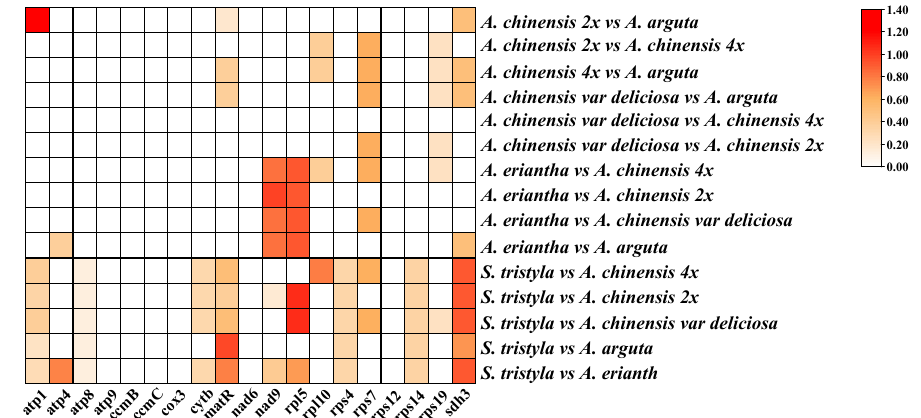
Figure 6. The pairwise Ka/Ks ratios among each mitochondrial gene in the six Actinidiaceae family species.